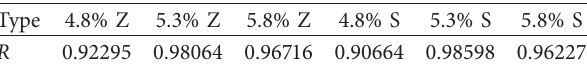
4.1.1. Model Concept and Hypotheses. Figure 7 represents the 3D model of a structural asphalt mixture element with a square cross-section. The small, solid block inside the square represents a microelement of the asphalt mixture. The hy- potheses are as follows.